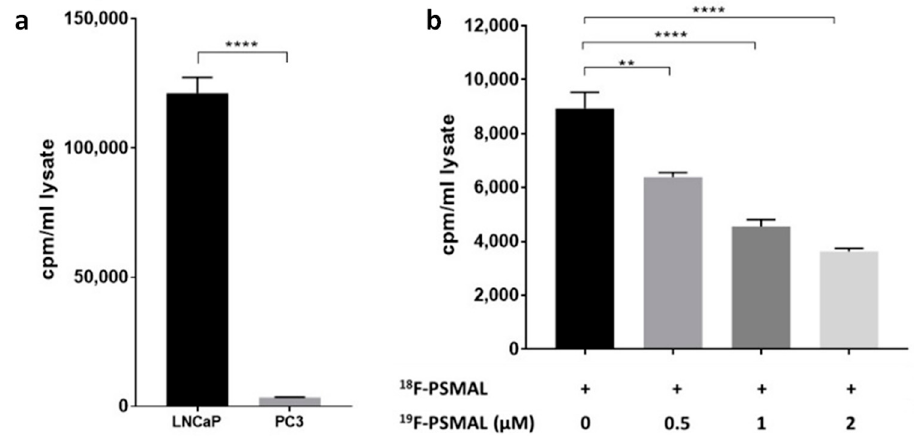
Figure 4. ( a ) Uptake of 18 F-radiolabeled PSMAL ( 18 F-PSMAL) in LNCaP and PC3 cells. ( b ) Interaction of 18 F-PSMAL with LNCaP cells in the presence of unlabeled PSMAL ( 19 F-PSMAL; compound 7 ) (** p = 0.0021, **** p < 0.0001).